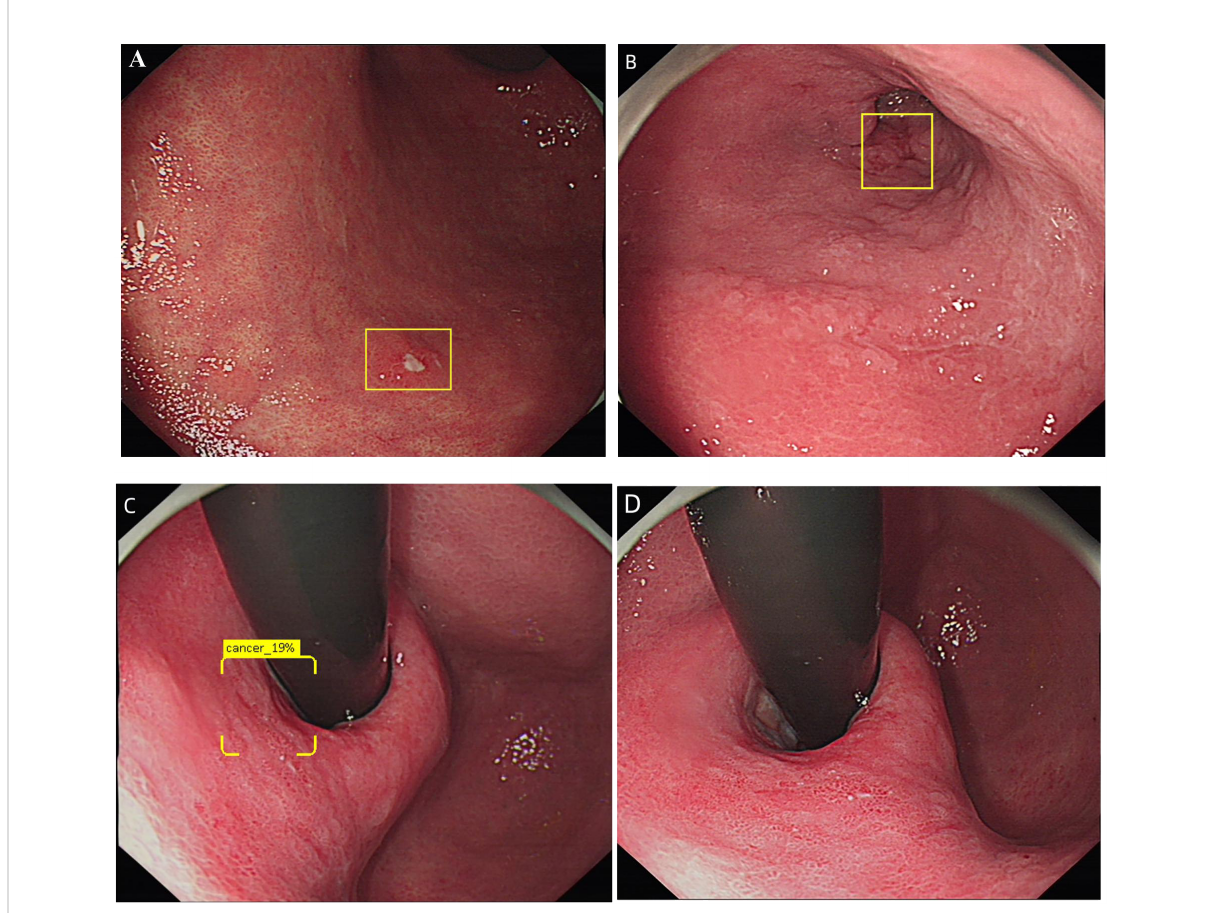
FIGURE 3 Diagram of DCNN producing false negatives. (A) Show an image that the lesions were too small to be recognized by DCNN. (B) Show an image of the lesions were too far to be recognized by DCNN. (C, D) Shows images taken from different shooting angles of the same lesion. (C) was effectively recognized as EGC by DCNN, while (D) was not recognized by